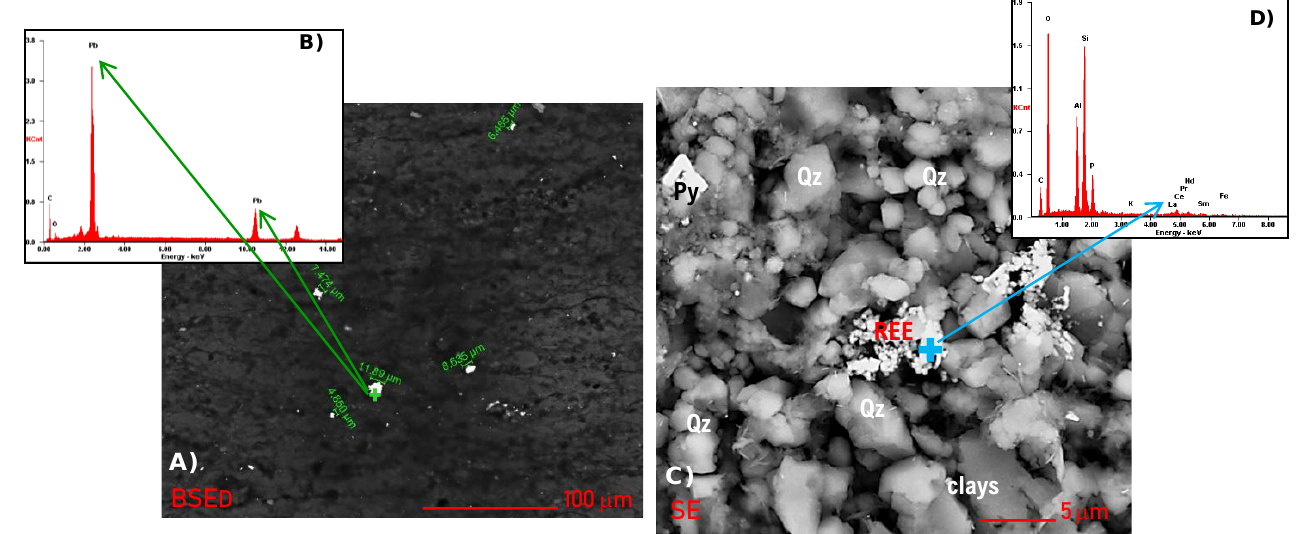
Figure 9. Detail of metals ( A ) and rare earths ( C ), identified by SEM within the Paja Formation, that accompany siliciclastic minerals, clays and others; at the extremes, the EDS spectra ( B , D ). ( A ) backscatter micrograph showing lead particles from 4.8 to 11.8 µ m in particle diameter; ( C ) SEM secondary electron image of a fine silt and clay (top 3.9 µ m, bottom) sized sediments, with quartz (Qz), iron sulfide (Py), REEs (see microanalysis report in text), and aluminosilicates (elements in the peaks, left, of the respective spectrum, ( D ), plus C and P. Note some scattered halloysite nanotubes. Too, a 4.5 µ m hexagonal phosphate (P: 11.57 wt%) was identified, very bright in